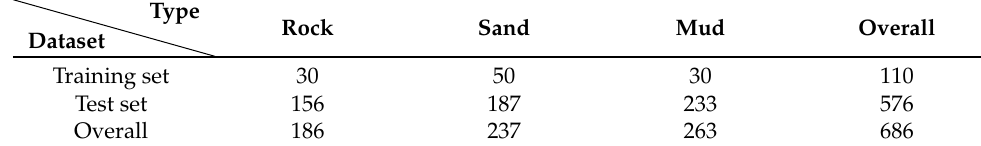
Table 1. The original dataset includes 686 samples of mud, rock, and sand.